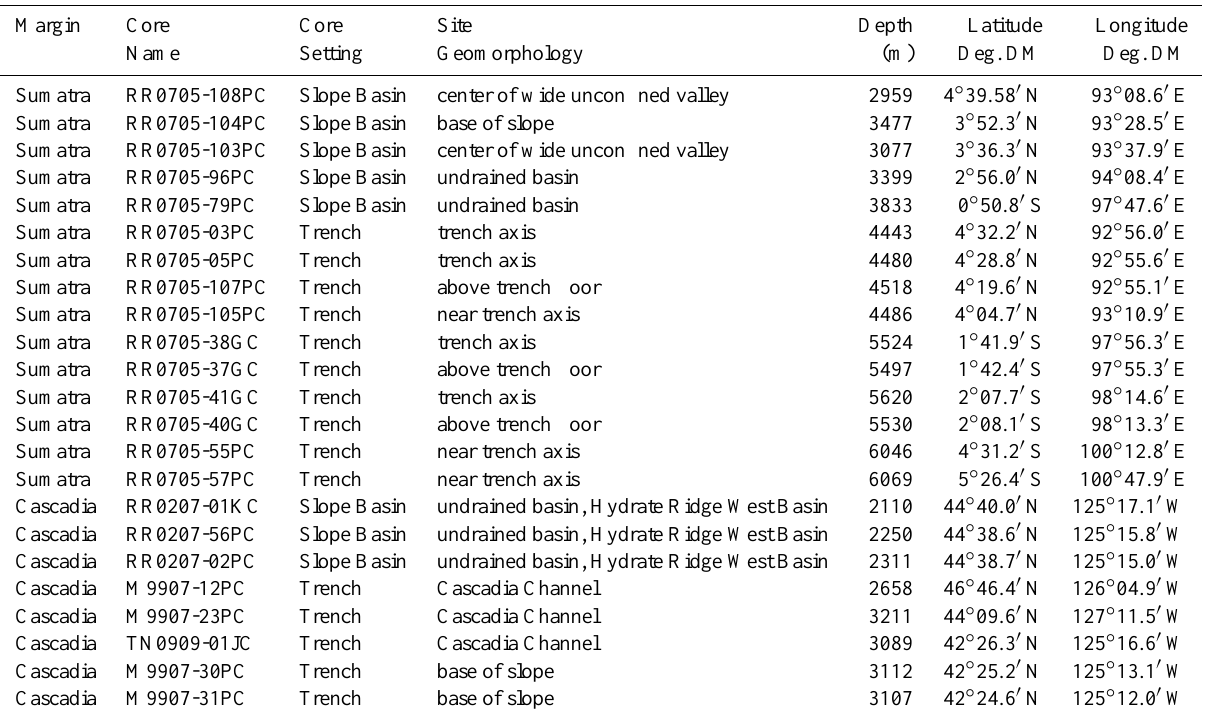
Table 1. Cores and their depositional